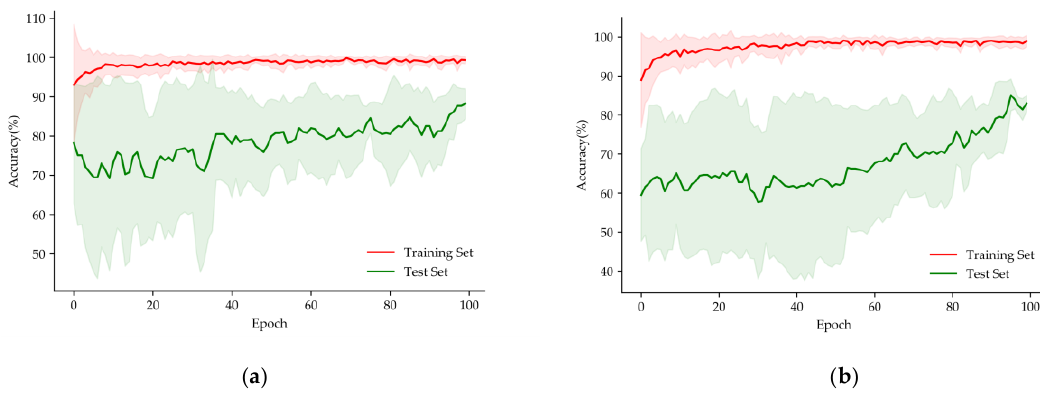
Figure 9. The change curve of accuracy during training by LCCDNNs. ( a ) C. elegans dataset, ( b ) zebrafish dataset.